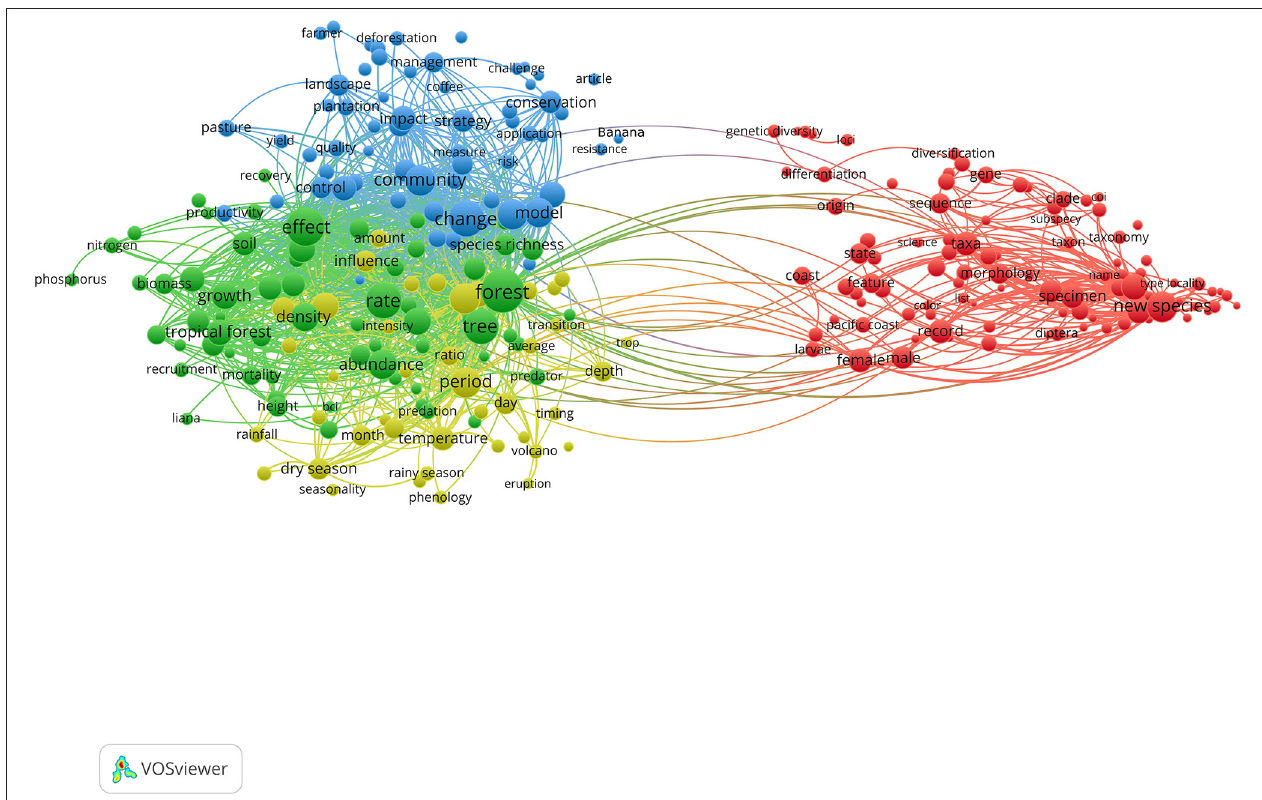
FIGURE 3 | Network visualization map of terms in title and abstract fields of documents in biodiversity topics in Central America. Minimum occurrences of each term was 100. Nodes with the same color represent a cluster of related terms (by VOSviewer 1.6.18).